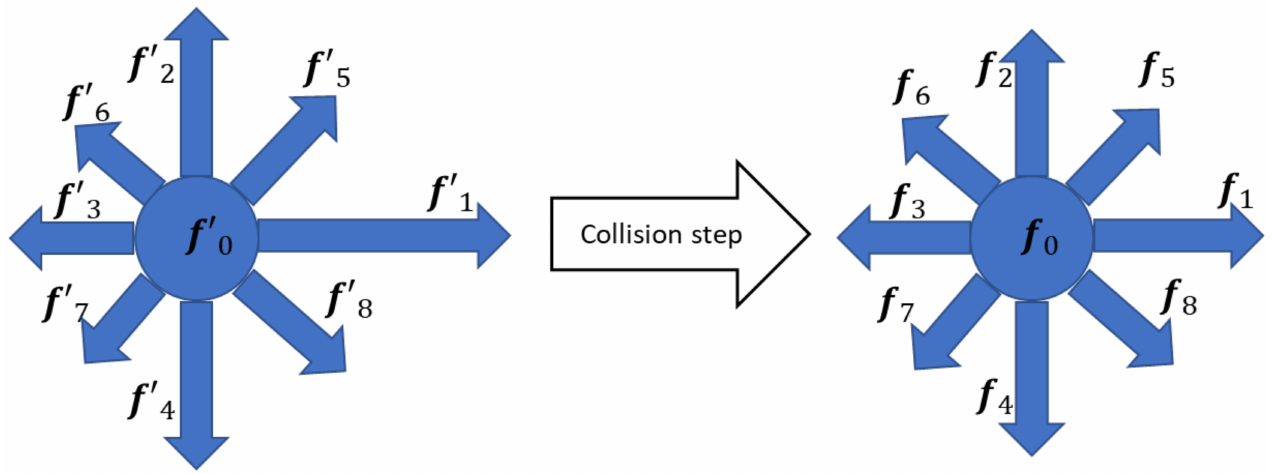
Figure 6. Change in the particles’ distribution in directions after collision step calculation. f (cid:48) the distribution of particles after the streaming step, f i is the distribution of particles after the collision